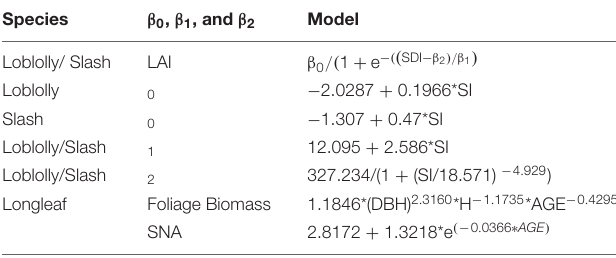
TABLE 3 | Parameters used for determining leaf area index for loblolly, slash, and longleaf pines. Species